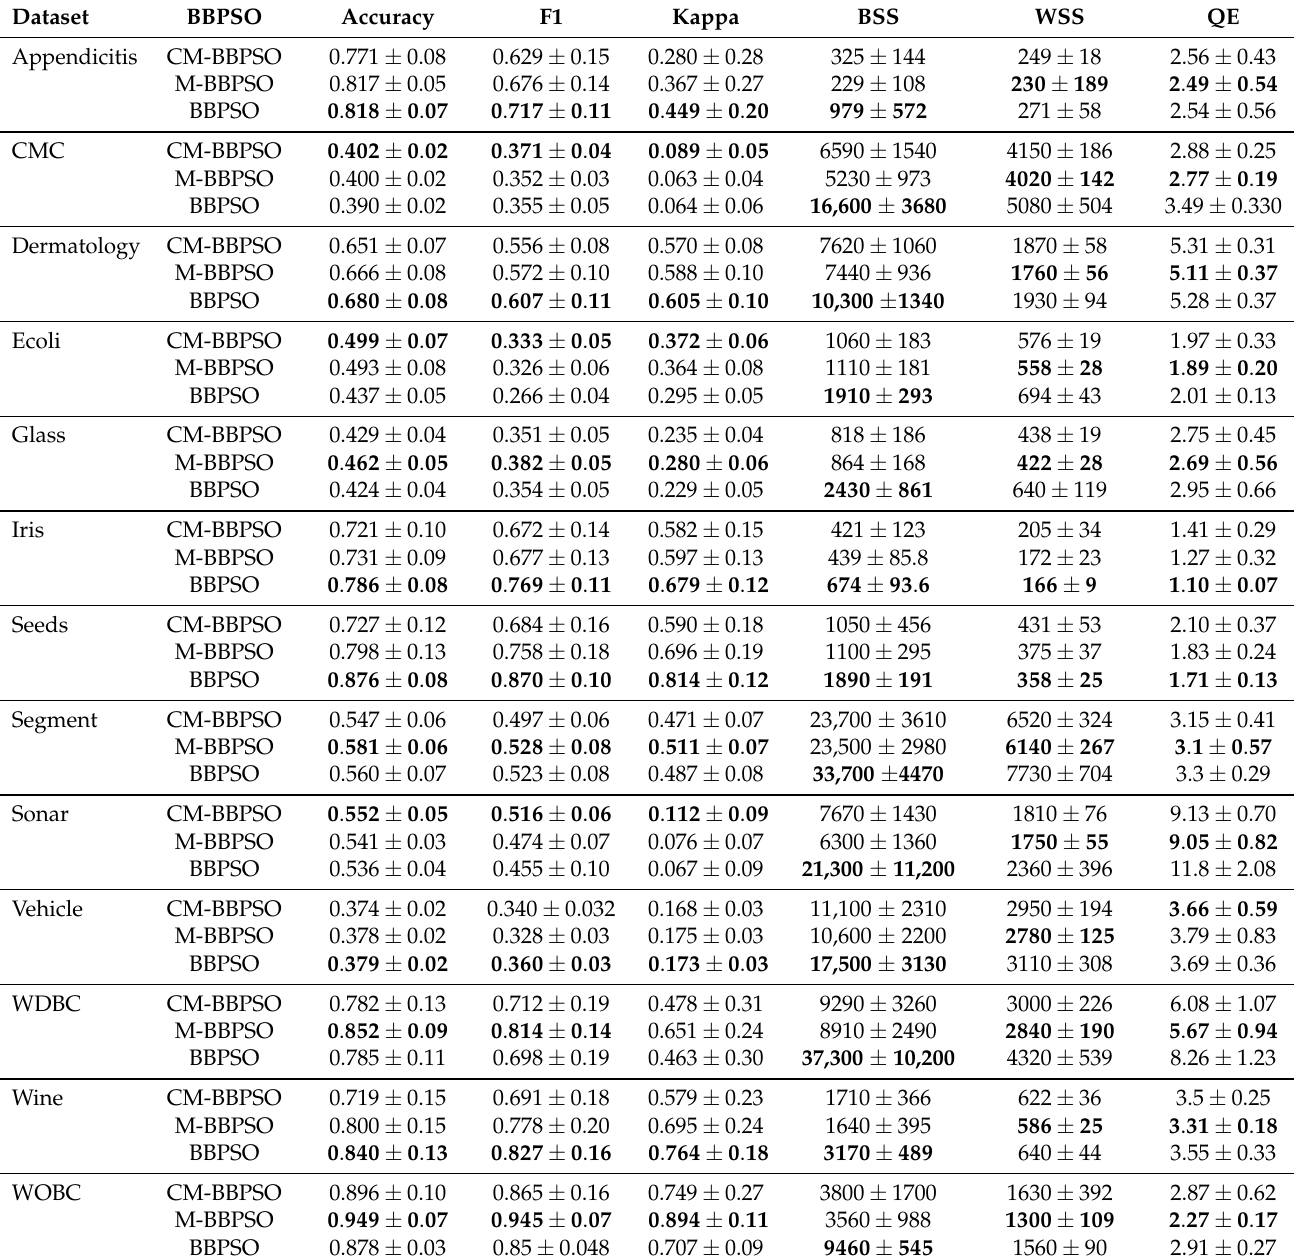
Table 1. Performance of cluster-based MOEA/D (CM), MOEA/D (M) and ordinary BBPSOs with the best result produced by the algorithm for each dataset presented in